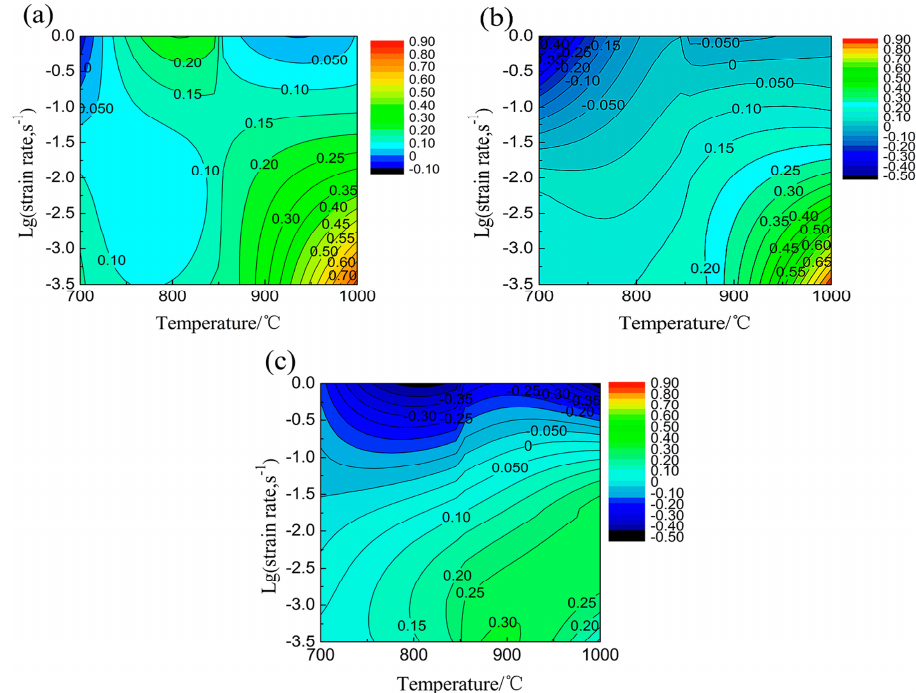
Figure 6. Instability maps of NiTiNb SMA based on various strains: ( a ) ε = 0.3; ( b ) ε = 0.6; and ( c ) ε = 9.0 =ε .